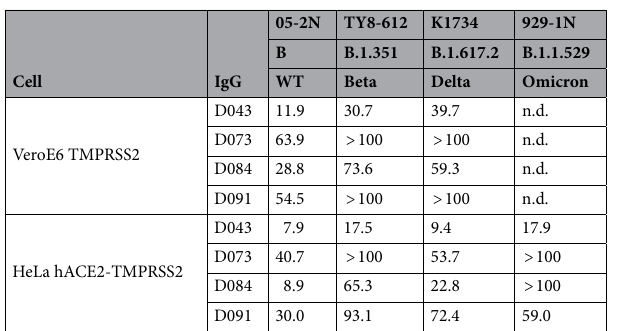
Table 2. Convalescent plasma antiviral activity of IgGs in HeLa hACE2-TMPRSS2 . Data are IC 50 (µg/ml)